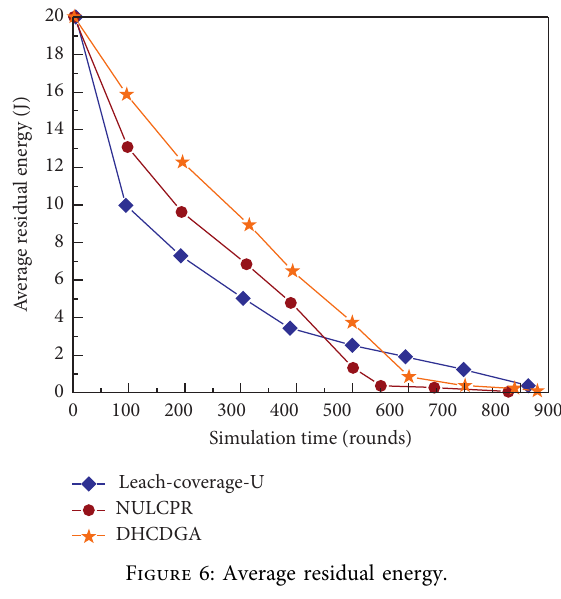
Figure 6: Average residual